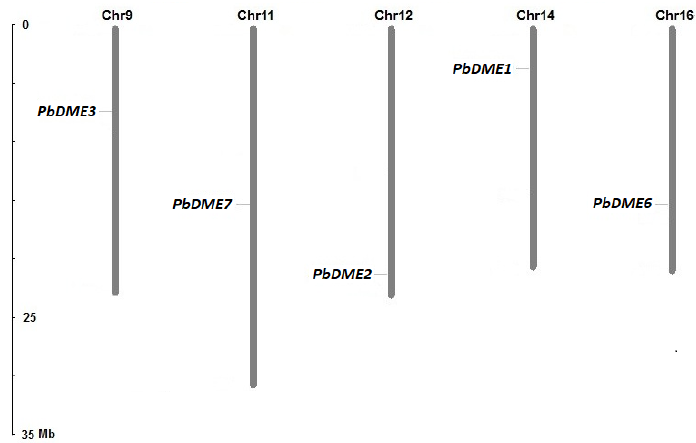
Figure 3. Chromosomal distribution of PbDME genes in pear. The Roman numerals on top of each chromosome represent the number of the chromosome. PbDME4/5 were both located on scaffold404.0. So, they were not included in this map.